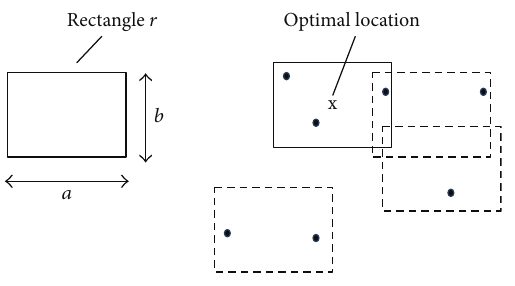
Figure 1: Example of the MaxRS query.